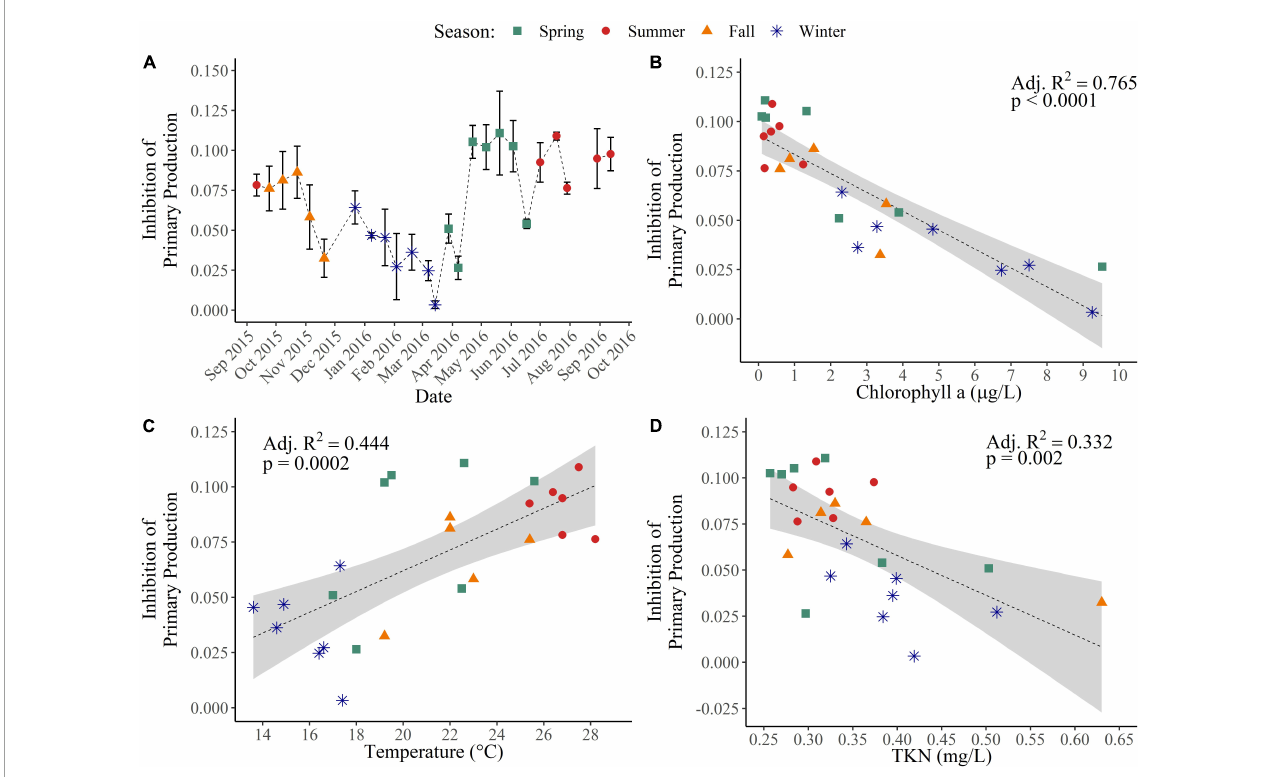
FIGURE4 Inhibition of primary production across seasons and environmental drivers. (A) Inhibition of primary production was determined through the fixation of 14 C-bicarbonate along triplicate dose response curves of 0, 0.5, 1, 2.5, 5, and 10% WAF treatment. Linear regressions of the inhibition of primary production with (B) chlorophyll a concentrations ( µ g/L), (C) with temperature ( ◦ C), and (D) with total Kjeldahl nitrogen (mg